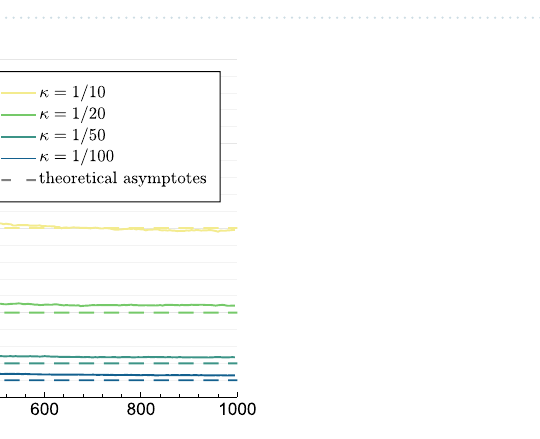
Figure 5. Comparison between the Euler scheme simulation ( (cid:31) t 1, κ 1 / 50 , the random walk approximation X 2 κ Dt in the quenched environment, and the annealed with D = = version with the correlated jumps and waiting times. (The PDFs are symmetrical, we only show the right half.) 10 the mass contained in the initial domain is dominating; for t In the regime t = 100 is the start of the Gaussian regime (in the semi-log space they are nearly corresponds to few jumps, t = parabolas).